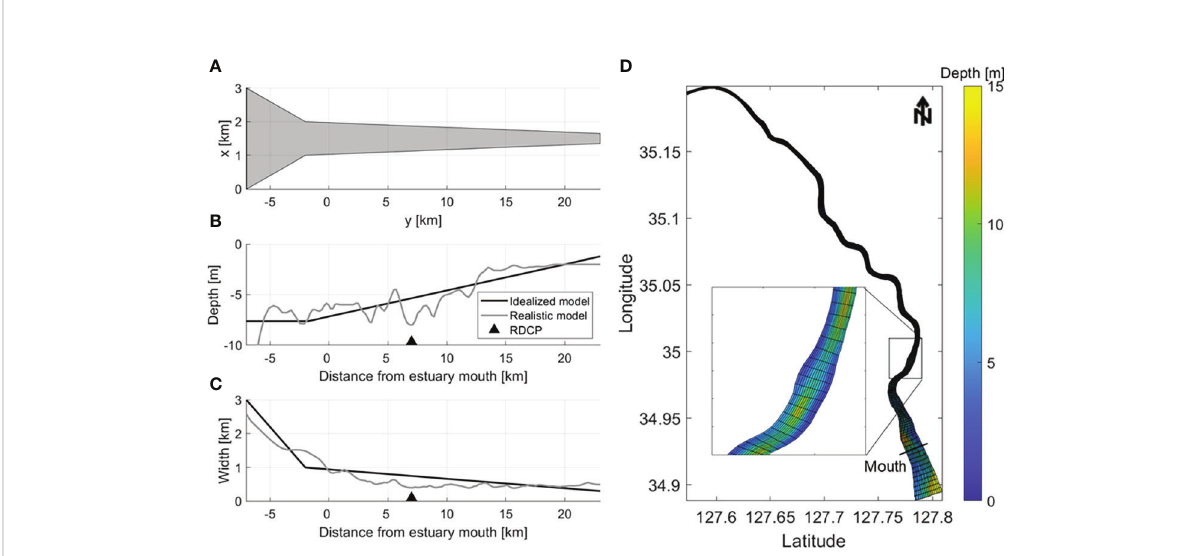
FIGURE 2 Idealized model domain information. (A) Idealized estuary model domain and the along-channel variations of (B) depth and (C) width for the model (black lines) and observations (grey lines) in the Sumjin River estuary. The observation depth is laterally averaged. The black triangles indicate the velocity observation station in Figure 1B RDCP. (D) Realistic model domain with depth (m); the estuary mouth is indicated by the black